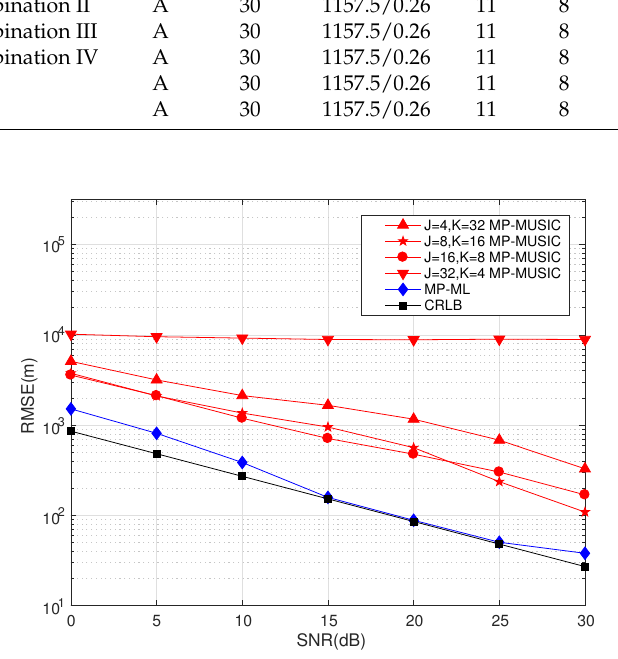
Figure 11. Performance of MP-ML and MP-MUSIC with different J , K